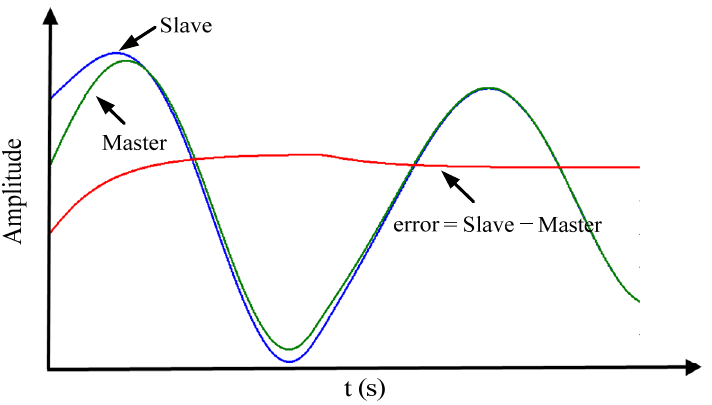
Figure 2. Synchronization of two chaotic